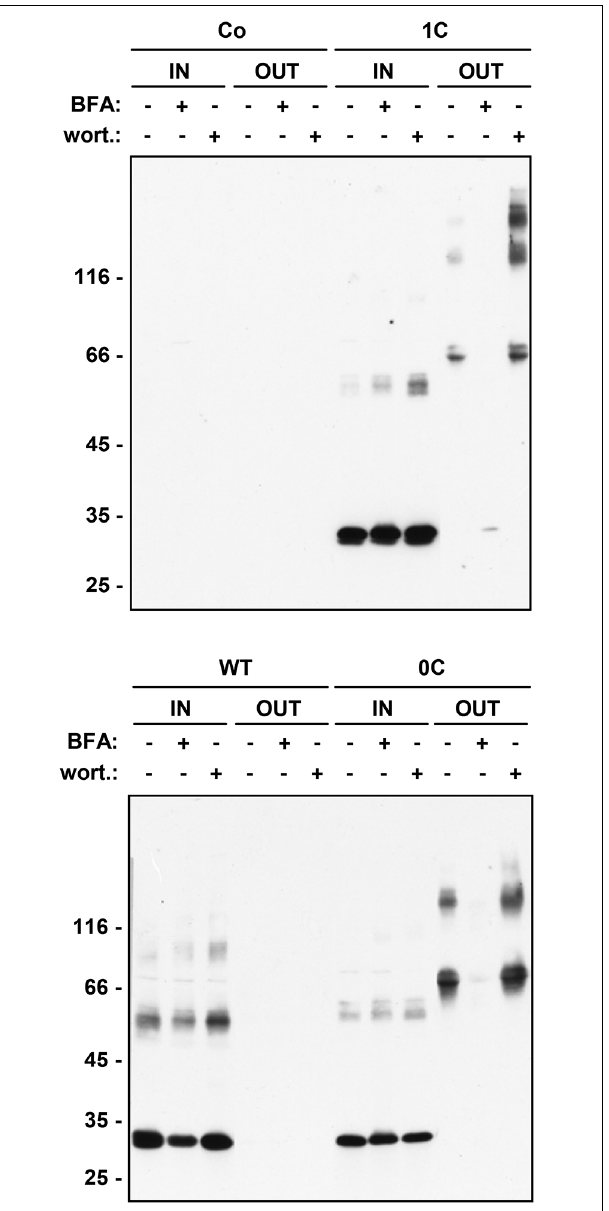
FIGURE 5 | Effect of intracellular traffic inhibitors on the secretion of γ -zein constructs. Tobacco protoplasts were transfected with plasmid containing the indicated γ -zein construct or with empty plasmid as control (Co). After 24 h incubation in the presence ( + ) or absence ( − ) of brefeldin A (BFA) or wortmannin (wort.), aliquots corresponding to equal number of protoplasts (IN) or the corresponding incubation medium (OUT) were analyzed by SDS-PAGE in reducing conditions, followed by protein blot using anti-flag antiserum. In each panel, numbers at left indicate the positions of molecular mass markers, in